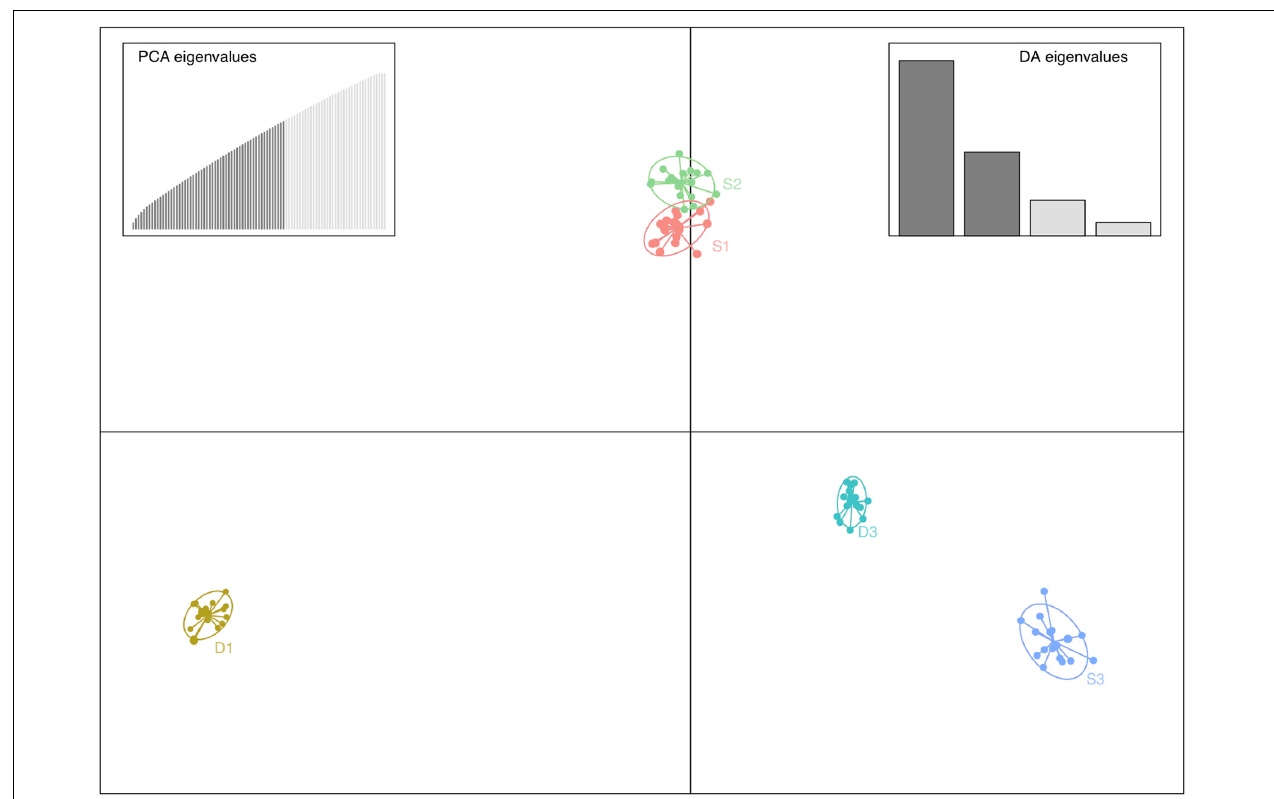
FIGURE 3 | Discriminant analysis of principal components (DAPC) showing that populations of Fucus vesiculosus, from the Öresund region, were clearly separated. The axes represent the first two linear discriminants. Colors indicate different populations, S indicates populations from the Swedish side of the strait, and D indicates populations from the Danish side. The subscripts 1–3 indicate populations from north to south (see Figure 1 ). The subplots show the number of principal components (PCA) and discriminant eigenvalues (DA) retained.